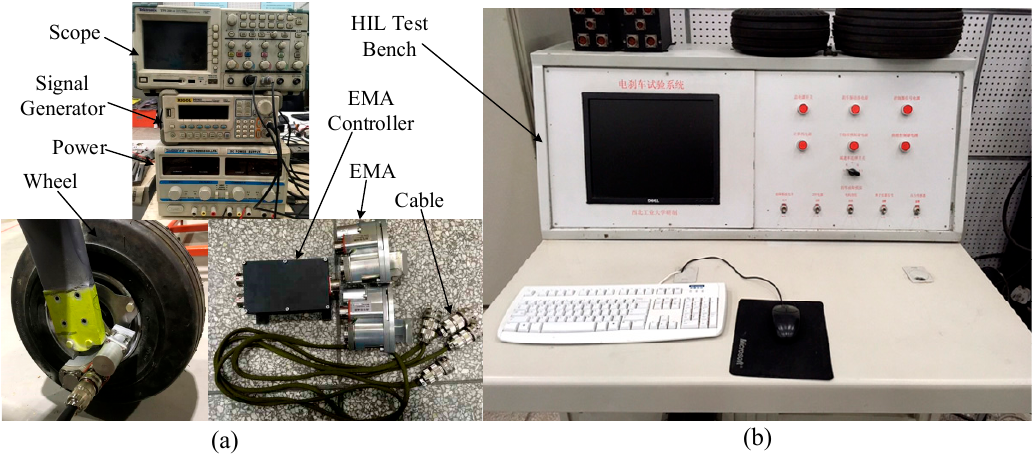
Figure 4. The electric braking system and the HIL test bench. ( a ) The EMA and the experimental equipment. ( b ) The HIL test bench of the electric braking system.